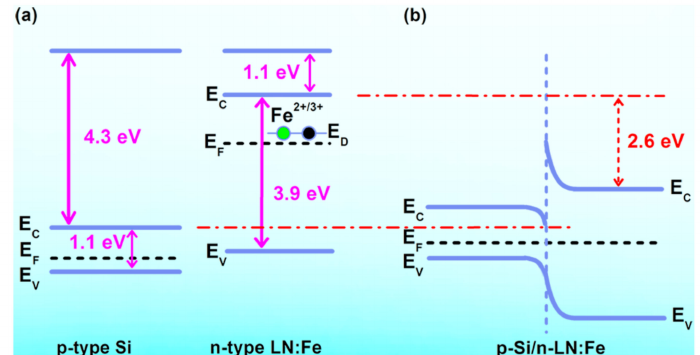
Figure 4. ( a ) Energy band diagram of isolated p-type Si and n-type LN:Fe 5 . ( b ) Energy band diagram of ideal LN:Fe 5 / Si heterojunction at thermal